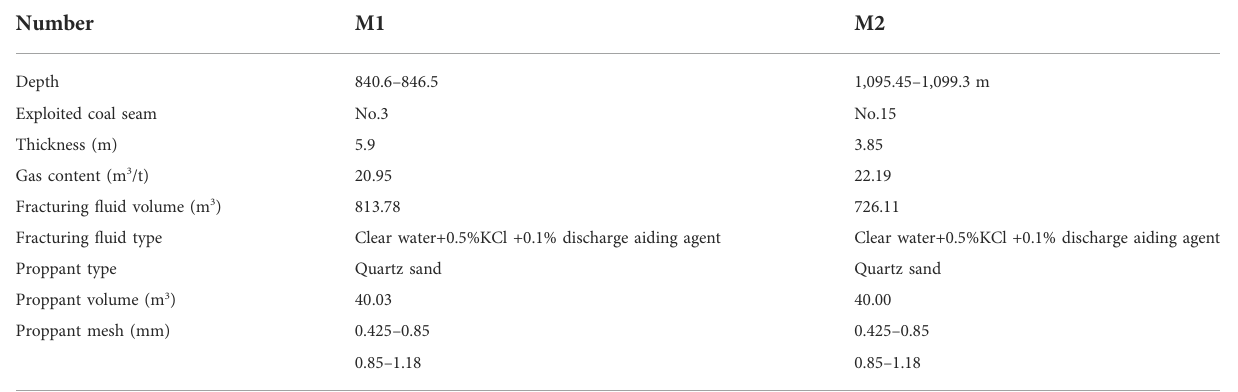
TABLE 5 Fracturing geology and operation